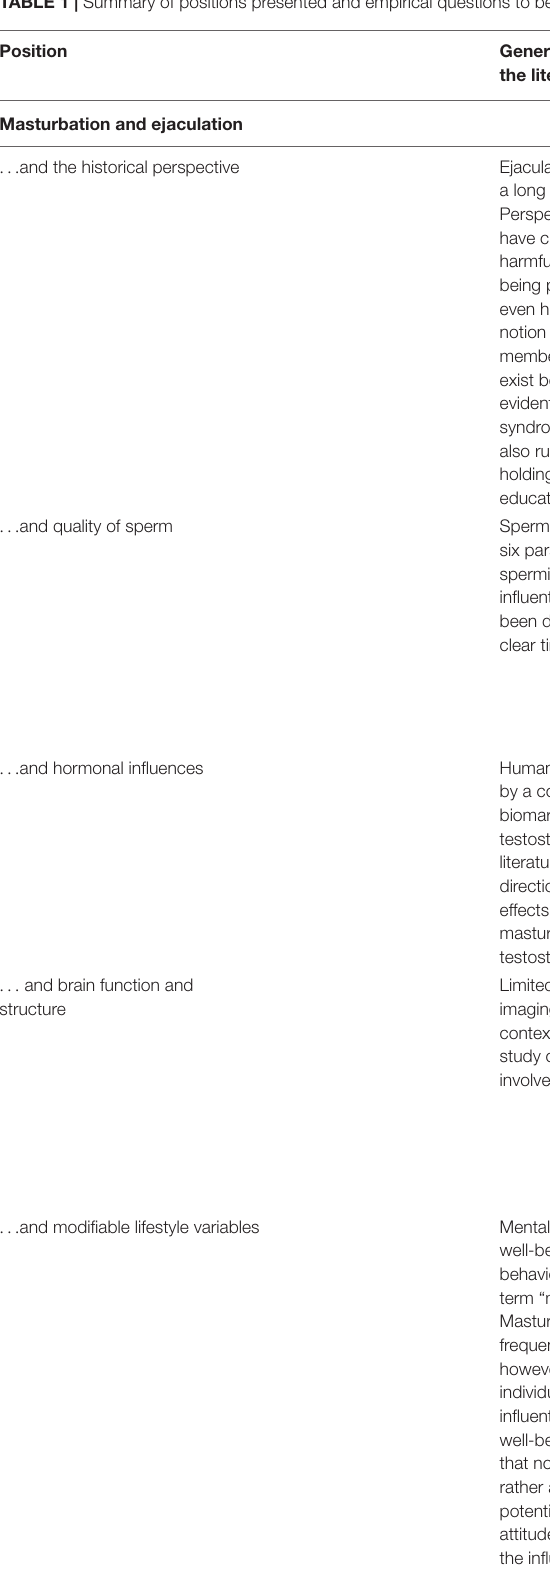
TABLE 1 | Summary of positions presented and empirical questions to be